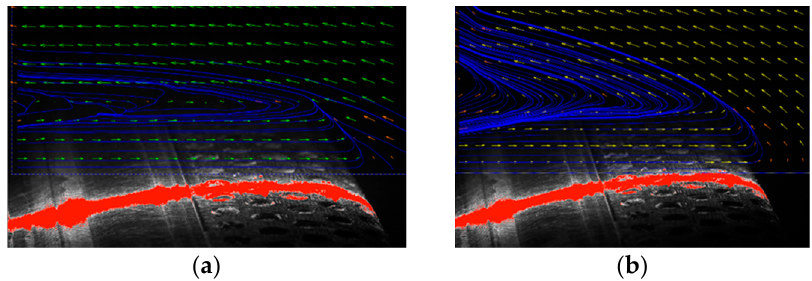
Figure 6. Average vector field superimposed to a sample raw image background (from one of the camera perpectives) at the center plane for 12-degree AoA ( a ) and 15-degree AoA ( b ). Vector fields and streamlines are the result of applying a convective velocity subtraction to vector field. Red reflection on airfoil surface indicates the laser-sheet thickness and dimple coverage (~9 mm).